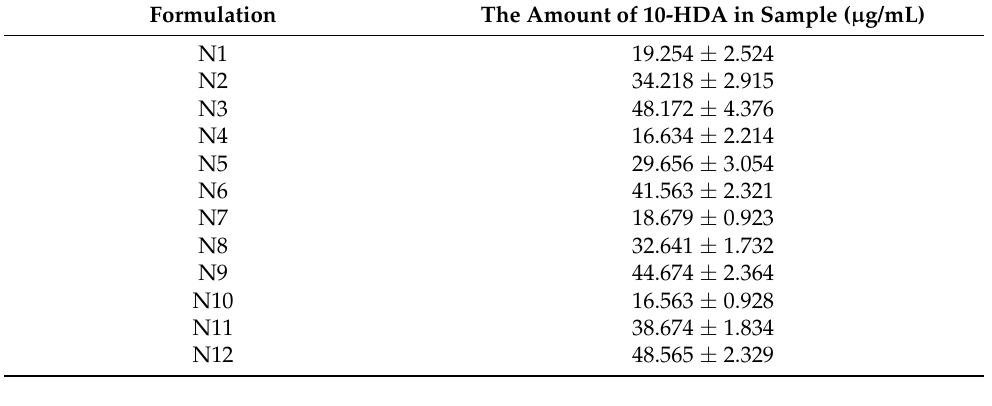
Table 6. The amount of 10-HDA in all formulations determined by HPLC. Data represent the mean standard deviation (SD), n = 3.